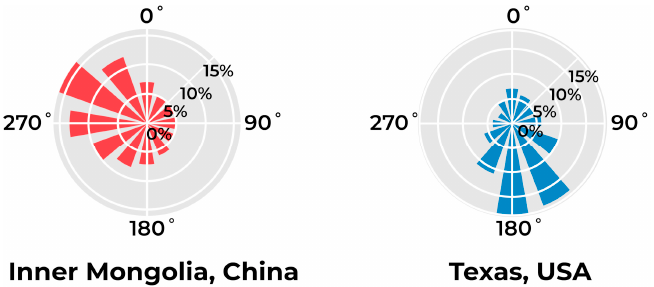
Figure 1. Wind-frequency roses for Inner Mongolia, China ( left ) and Texas, USA ( right ). The circular format of the wind rose shows the direction the winds blew from and the length of each “spoke” around the circle shows how often the wind blew from that direction. These wind roses do not provide the wind speed.